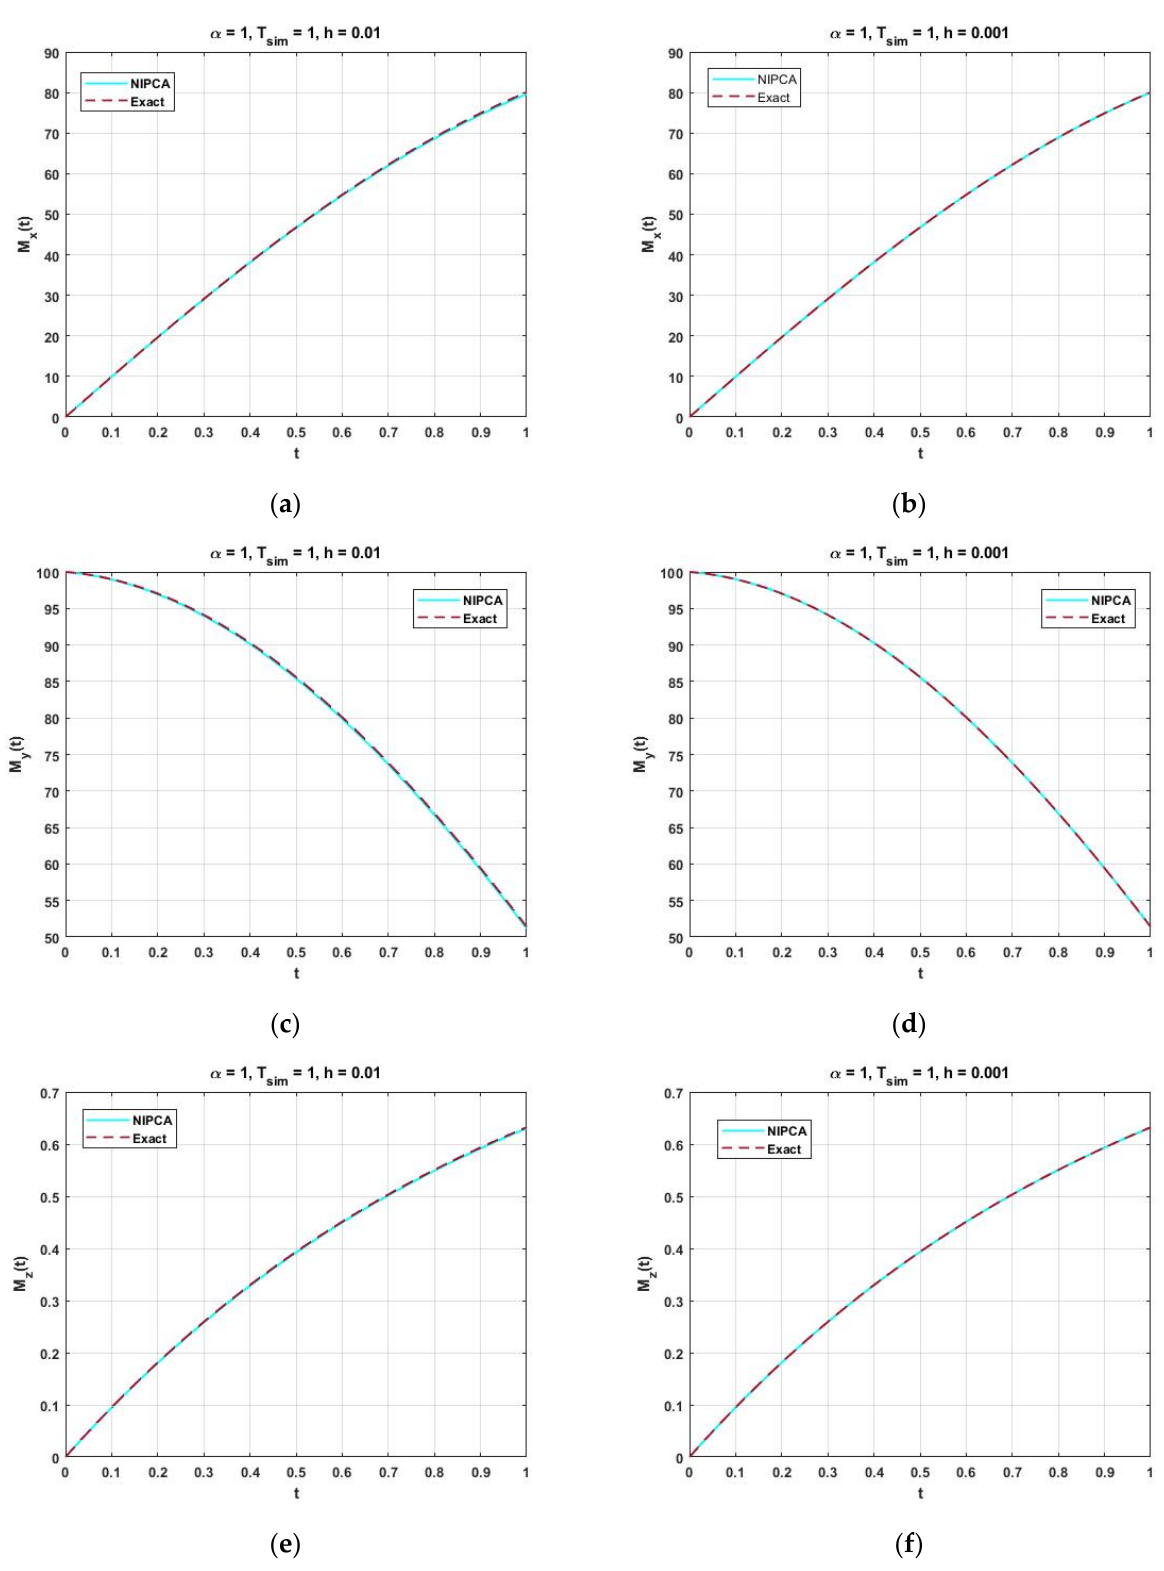
Figure 8. Comparison between the Exact solution and Analytical solution of the FNMRF system for ( a ) ℎ (cid:3404) 0.01 ( b ) ℎ (cid:3404) 0.001 ( c ) ℎ (cid:3404) 0.01 ( d ) ℎ (cid:3404) 0.001 ( e ) ℎ (cid:3404) 0.01 ( f ) ℎ (cid:3404) 0.001 and initial condi ‐ tion (cid:4672)𝑀 (cid:3051) (cid:4666)0(cid:4667), 𝑀 (cid:3052) (cid:4666)0(cid:4667), 𝑀 (cid:3053) (cid:4666)0(cid:4667)(cid:4673) (cid:3404) (cid:4666)0,100,0(cid:4667) for 𝑇 (cid:3046)(cid:3036)(cid:3040) (cid:3404) 1 s